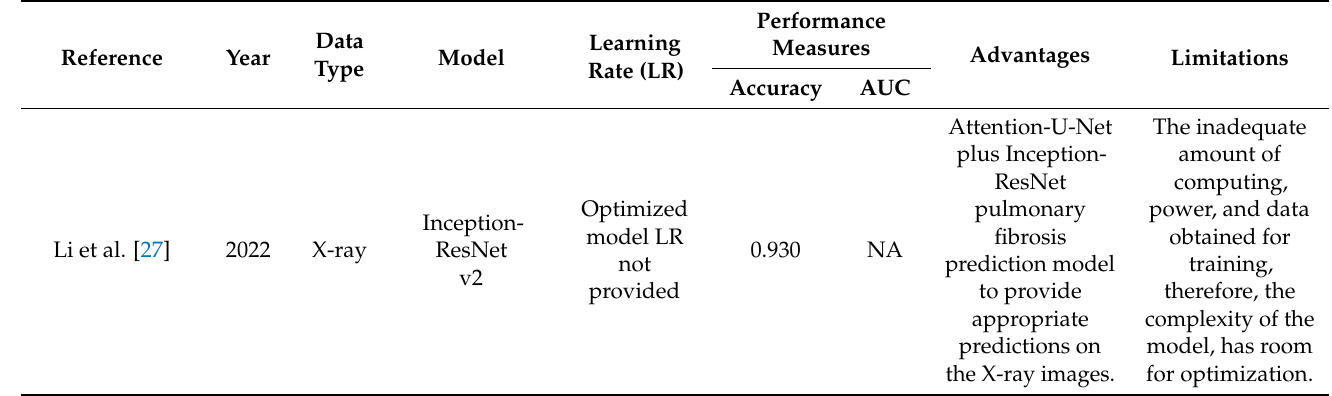
Table 1. A list of related studies on PF classification and their corresponding advantages and